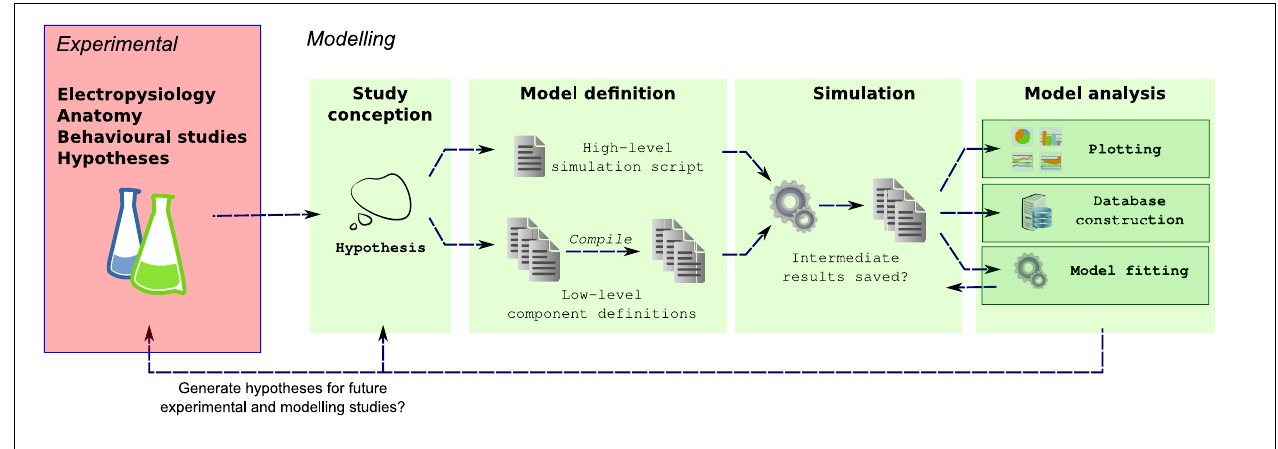
FIGURE 1 | Multiple steps using a variety of libraries, tools and languages are often required from the conception to the evaluation of a modeling hypothesis. During model definition , the computational model must be defined for a specific simulator (e.g., NEURON), which can involve writing several interdependent files in different, domain specific languages,